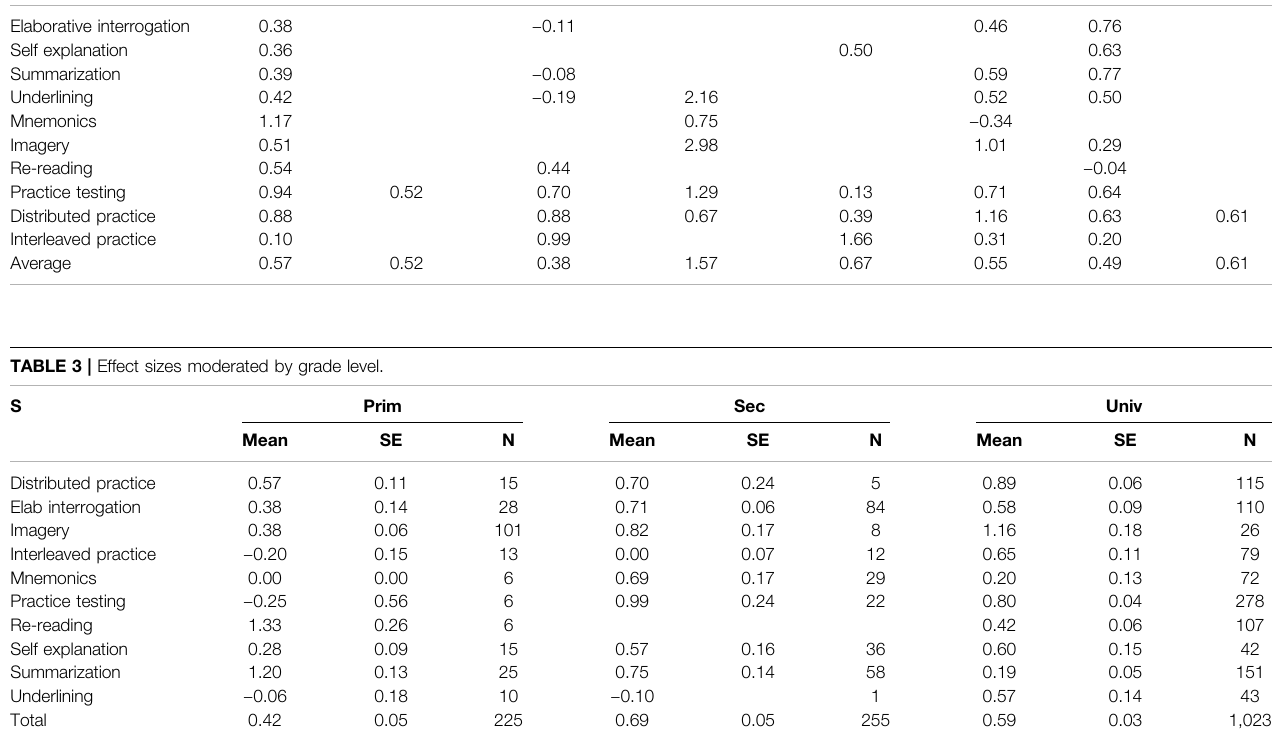
TABLE 2 | Effect Sizes moderated by the Learning Domain. Effect sizes